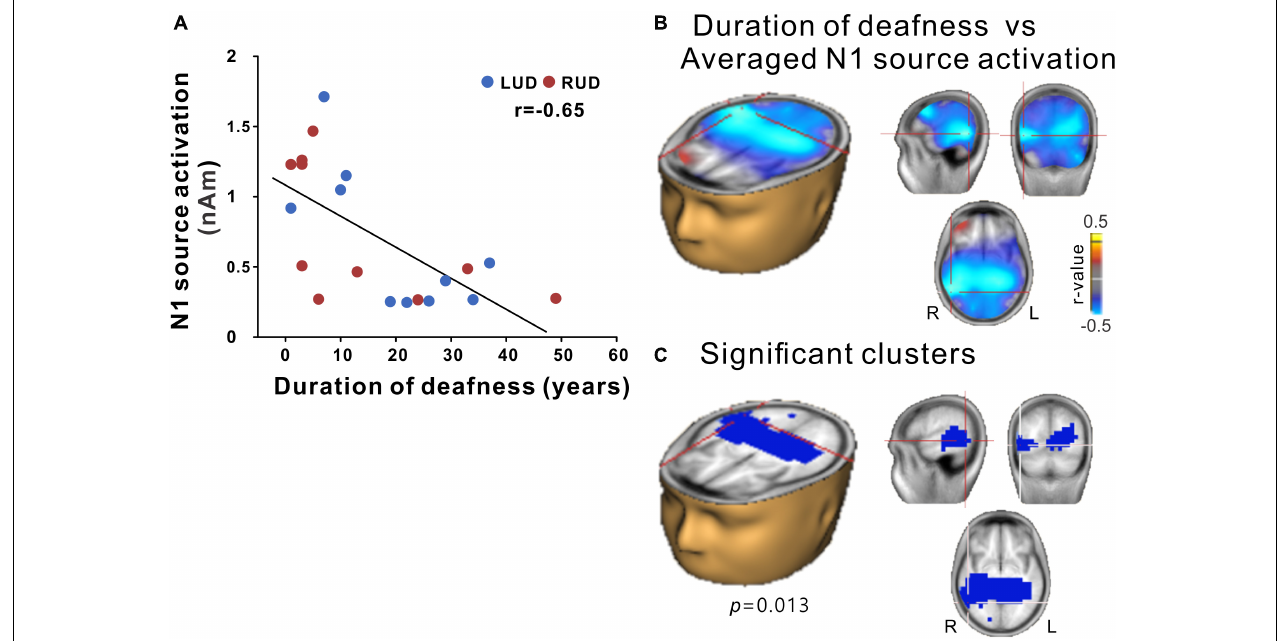
FIGURE 7 | (A) N1 source activation correlation with the duration of deafness. (B) Voxels representing correlations between the duration of deafness and the averaged N1 source activation across the RUD and LUD groups. (C) Correlation data for voxels with peak correlations (crosshairs). Note that significant clusters were found in a broad region of the brain encompassing the bilateral temporal and occipital lobes with lateralization in the right hemisphere. RUD, right-sided unilaterally deaf; LUD, left-sided unilaterally